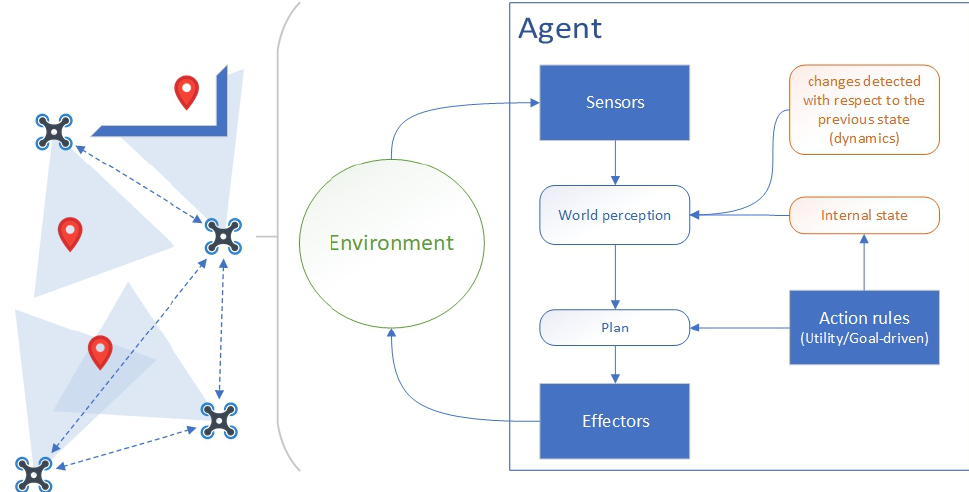
Figure 1. Hide-and-seek problem with a sensor-based system as a MAS and an example of conceptual agent reasoning based on maximising utility according to its goals